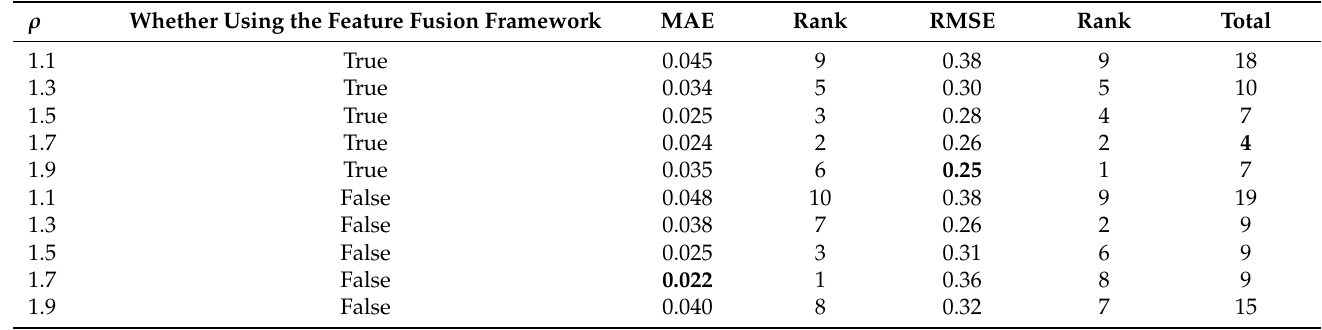
Table 3. The performance after optimizing